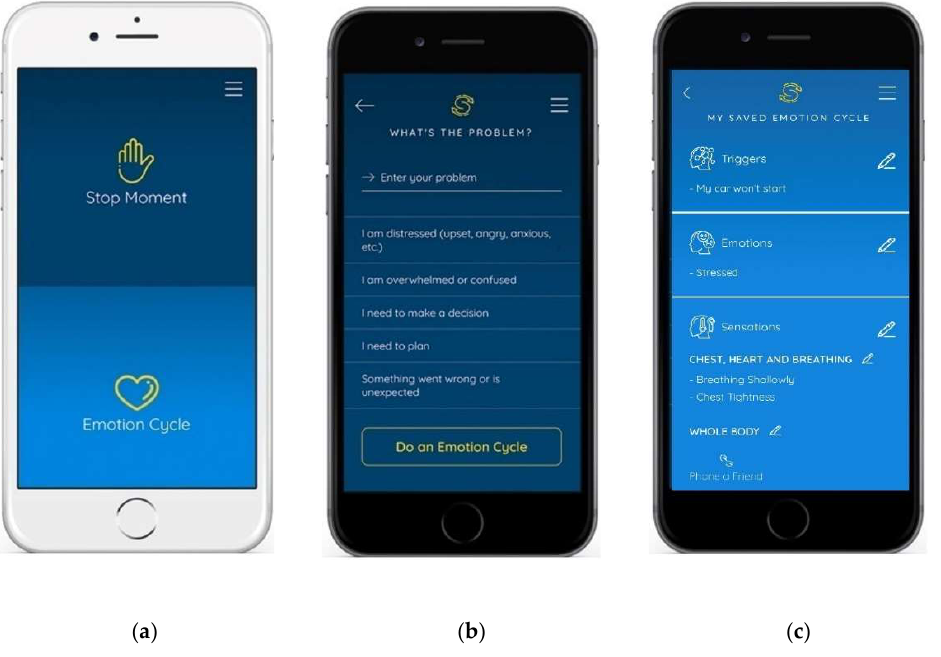
Figure 1. SwapMyMood app: ( a ) The home screen provides user with options to begin the SWAPS problem-solving strategy by entering a Stop Moment or to begin an Emotional Cycle. ( b ) The “What’s the Problem” screen guides the user to complete a step in the SWAPS problem-solving strategy by identifying the problem, and it also provides the option for the user to incorporate completion of an Emotional Cycle to help identify all parts of the problem, including how it is affecting them. ( c ) The “My Saved Emotion Cycle” screen displays user identified aspects of the Emotional Cycle strategy in an editable format.